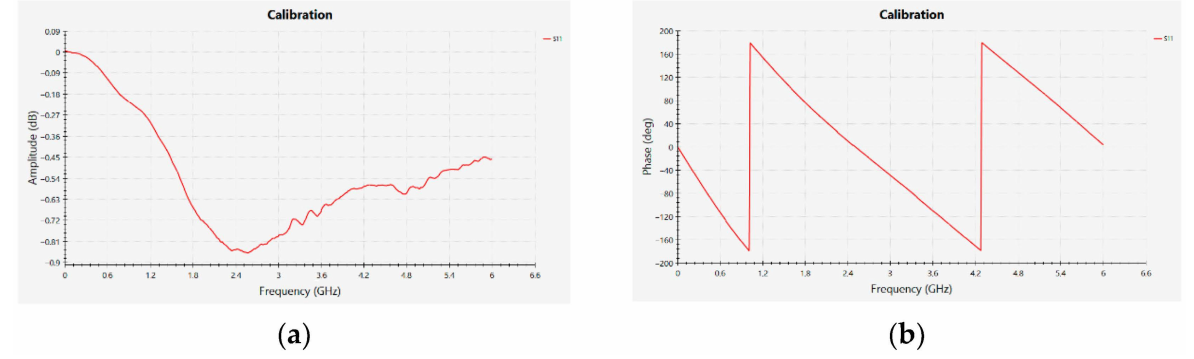
Figure 4. The calibration results of the measurement system: ( a ) amplitude curve, ( b ) phase curve of the Compass Technology measurement device.